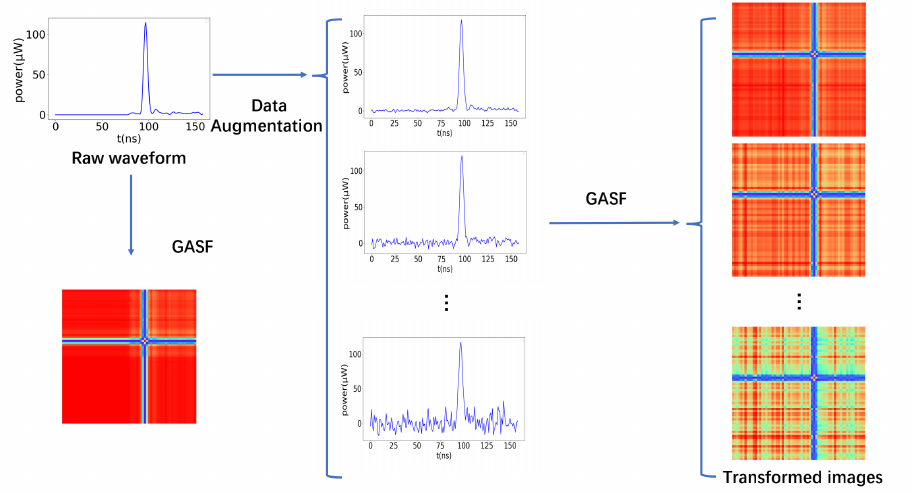
Figure 8. Workflow of data augmentation.